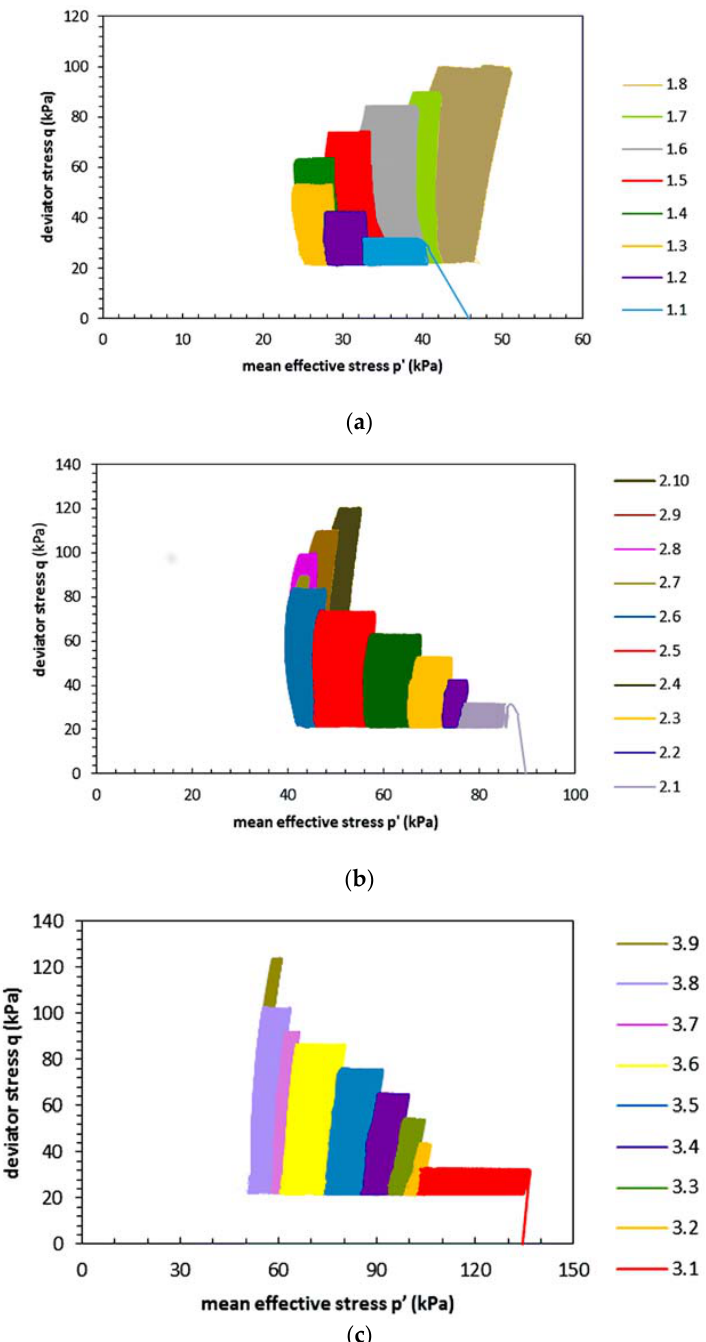
Figure 4. Stress paths for different test conditions: radial stress equal to σ ’ 3 ( a ) 45 kPa; ( b ) 90 kPa; and ( c ) 135 kPa, as defined in Table 2.